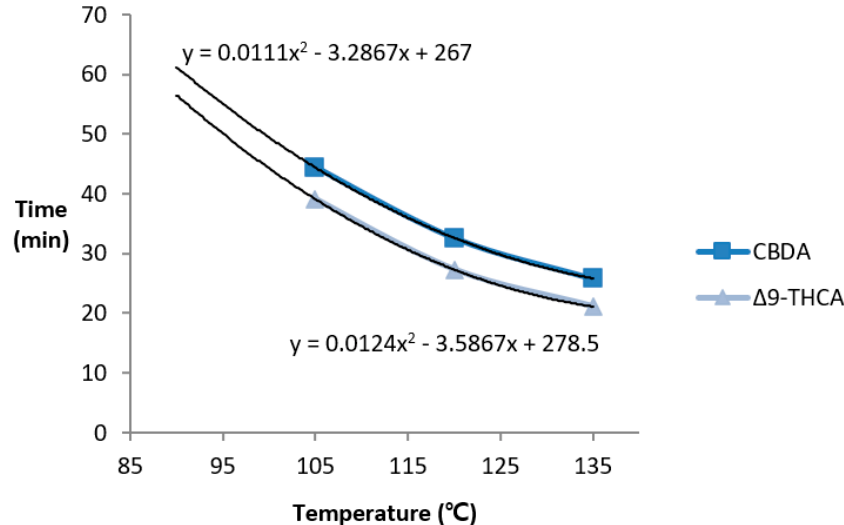
Figure 7. Time for 50% decarboxylation (DT 50 ; when acidic cannabinoids are reduced to half) de-